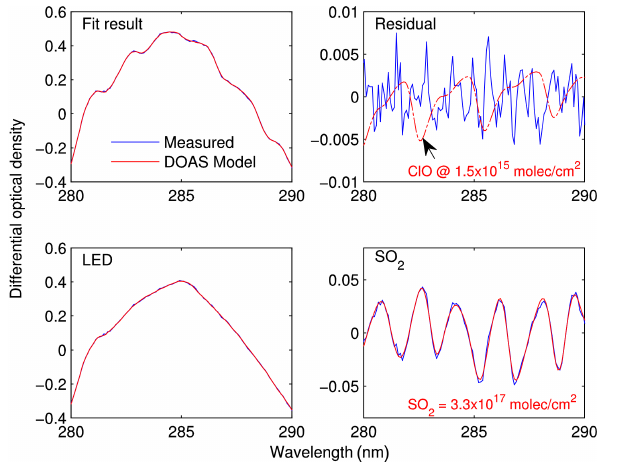
Figure 4. Evaluation of SO 2 absorption in the measured spec- tra. The absorption cross section of SO 2 was fitted to the dif- ferential optical depth. In this example evaluation, a column density of 1.5 × 10 17 moleccm − 2 was retrieved. The detection limit of ClO was derived by comparing the fit residual with the absorption features of a hypothetical column density of 1.5 × 10 15 ClOmoleccm − 2 . See text for